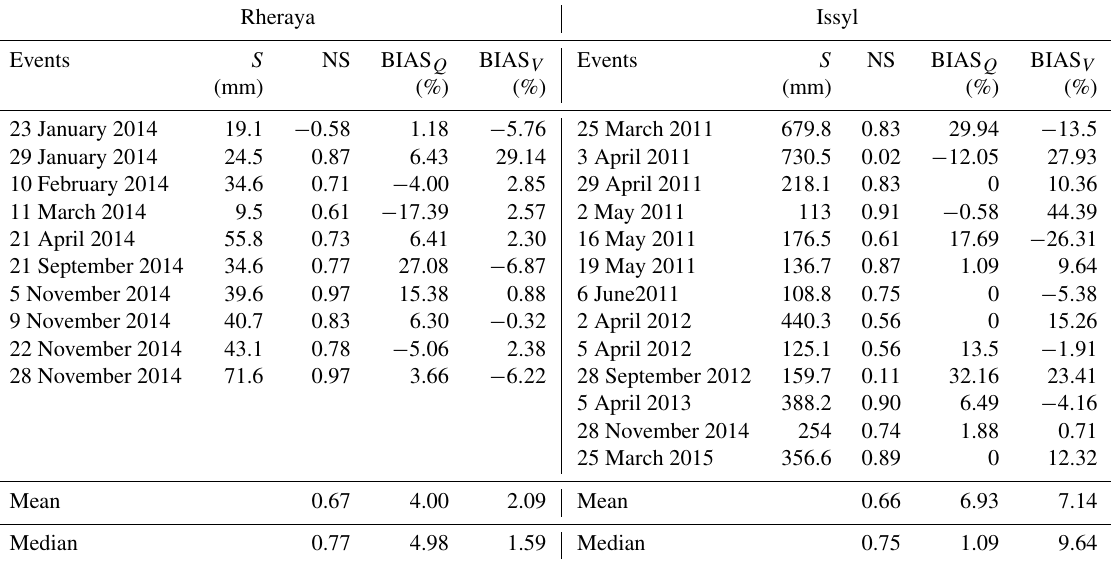
Table 6. Calibration results of the SCS-CN model: S is the potential maximum soil moisture retention; BIAS Q is the difference between the observed and calibrated peak discharge of the event; BIAS V is the difference between the observed and calibrated volume of the event. Rheraya